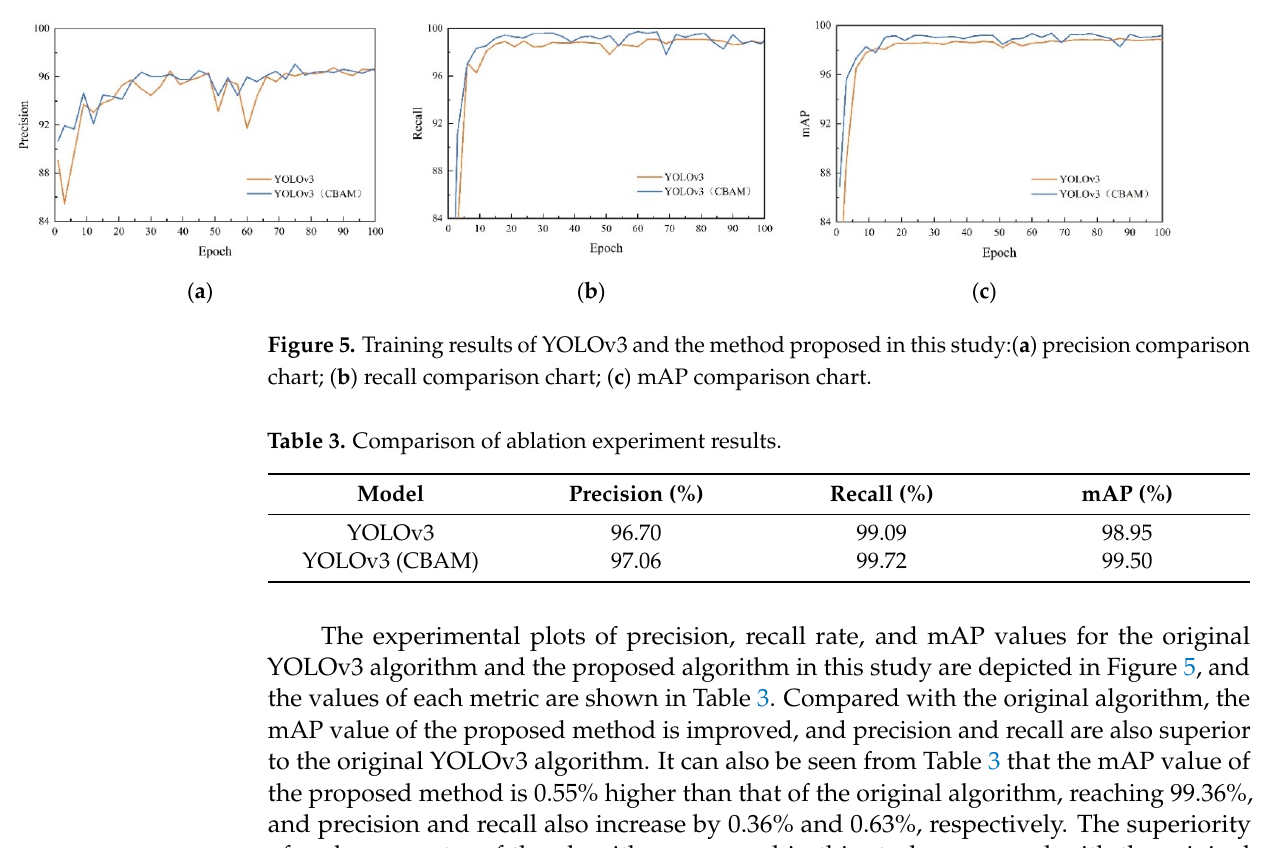
Table 4. Comparison of detection results of different models.